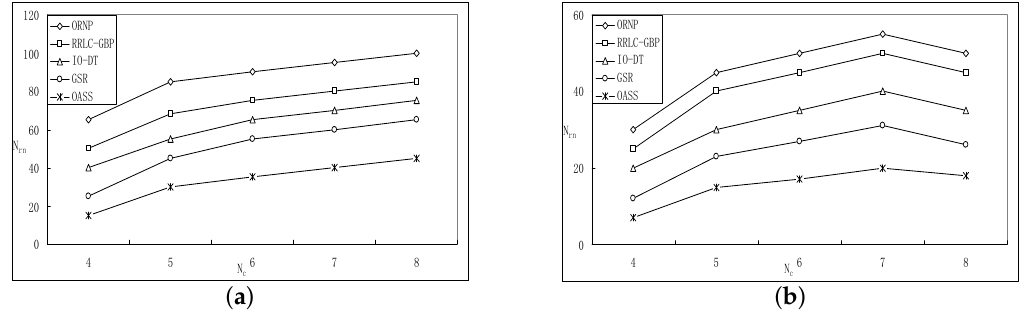
Figure 7. The effect of varying N c on the performance of OASS compared with all baseline approaches w.r.t. ( a ) when r = 50 m; ( b ) when r = 190